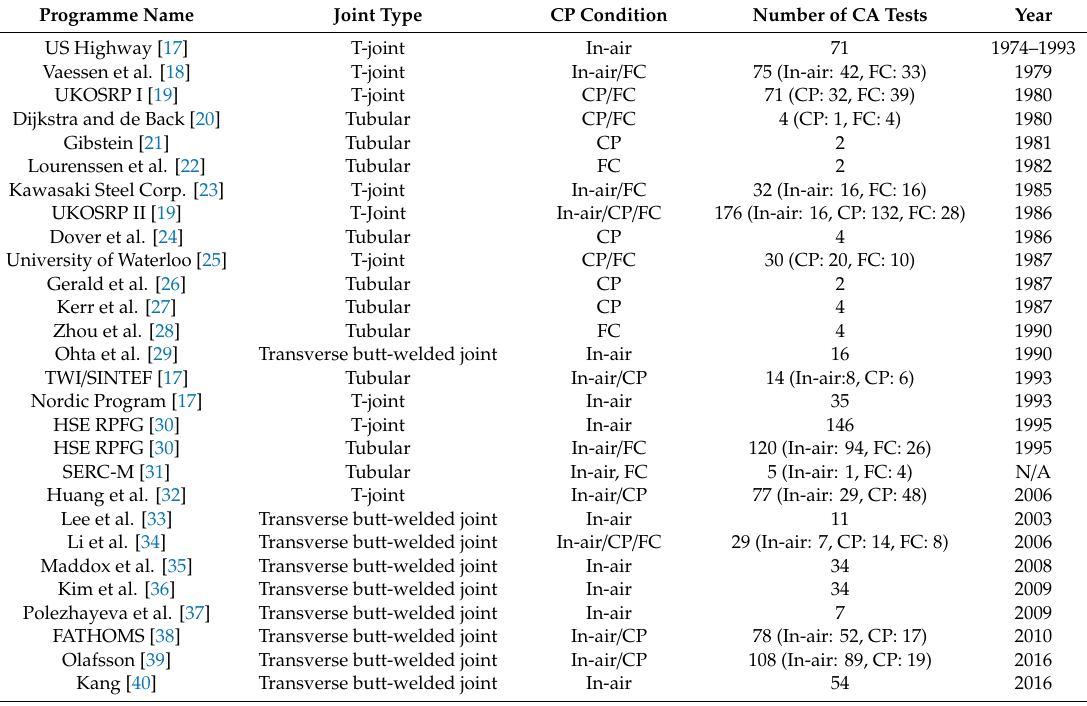
Table 2. Source list of fatigue test